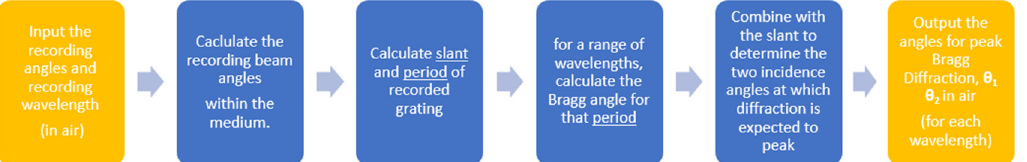
Figure 6. Flowchart to find the Bragg angles for different wavelengths.